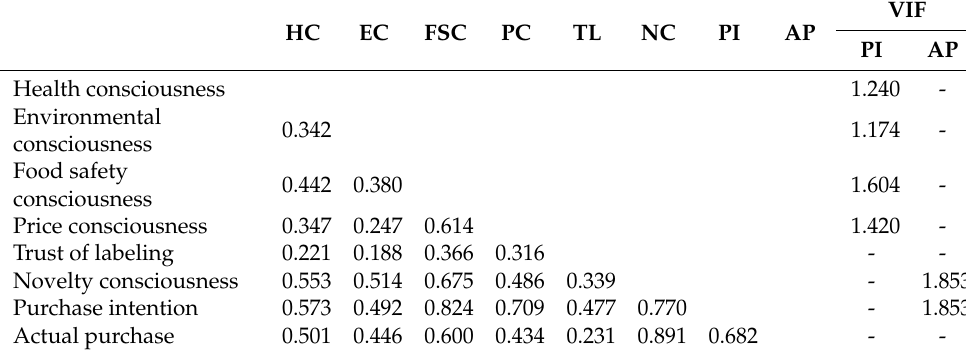
Table 3. Heterotrait–Monotrait Ratio